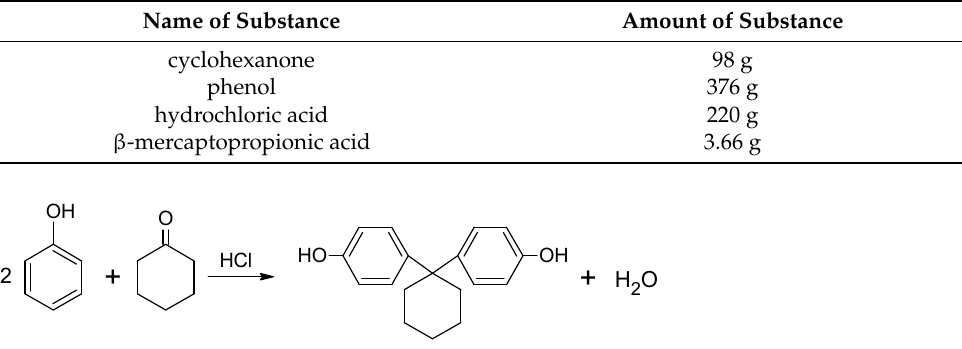
Table 1. Amounts of chemical compounds used for bisphenol Z preparation.